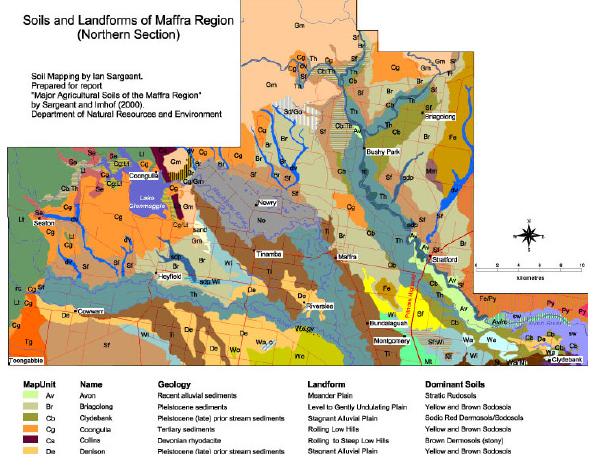
Figure 1. Soil/landform map of the Maffra region in